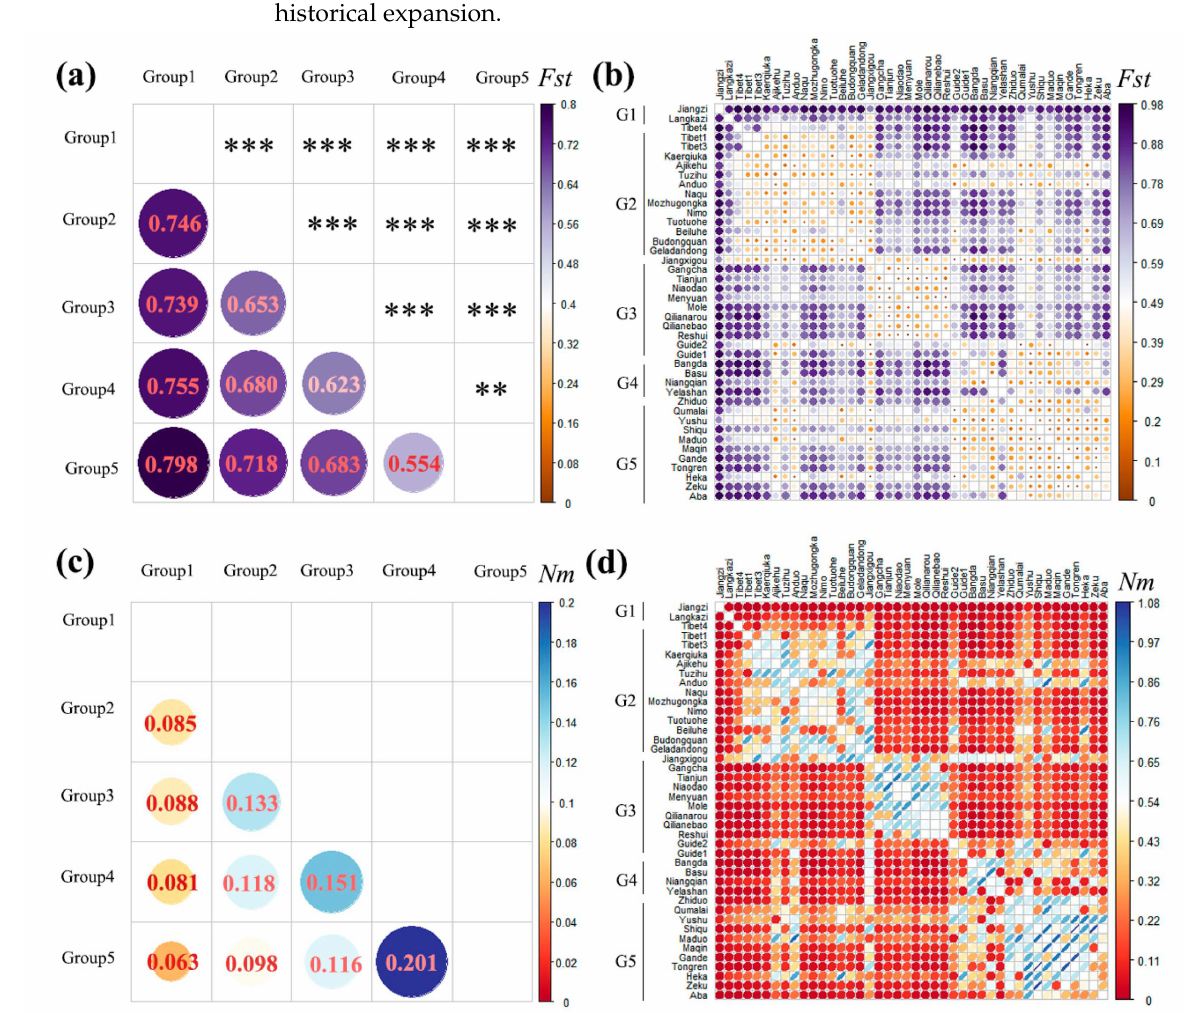
Figure 2. F st and N m values among populations and groups of plateau pika based on the combined dataset ( 12S rRNA + COI + D-loop + Cytb + GHR + IRBP + RAG1 ). ( a ) F st value of the group; the diago- nal indicates the level of significance, ** p < 0.01; *** p < 0.001; ( b ) F st values of 42 populations, G1–G5: Group 1–Group 5; ( c ) N m value of group; ( d ) N m value of 42 populations, G1–G5: Group 1–Group 5. Table 6. Neutral test and mismatch analysis of different lineages of plateau pika in the